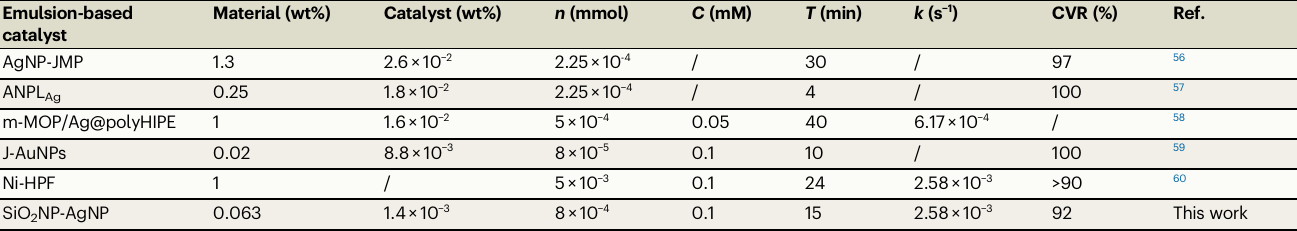
Table 1 | Emulsion-based interfacial catalysis Emulsion-based